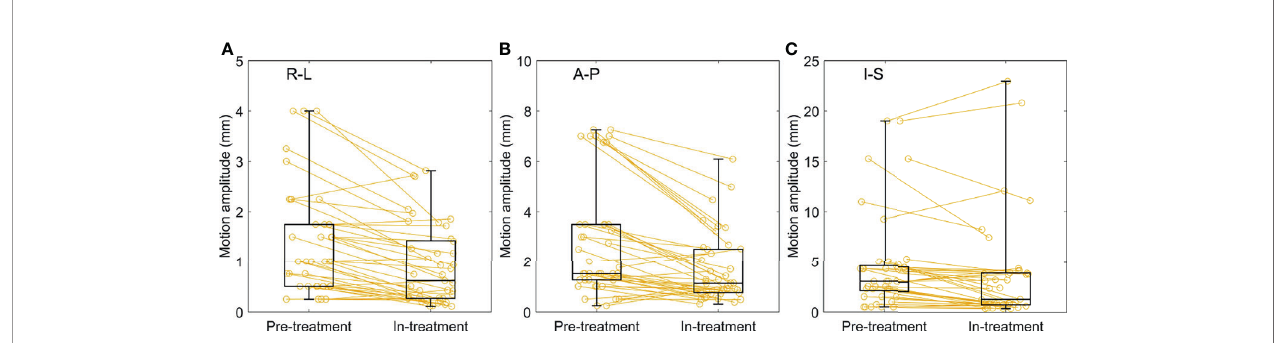
FIGURE 7 | Comparisons of the pretreatment and in-treatment motion amplitudes across 41 treatment fractions of 31 SABR plans in the (A) R-L, (B) A-P, and (C) I-S directions, respectively. The mean values were presented for in-treatment motion amplitudes. SABR, stereotactic ablative radiotherapy; R-L, right-left; A-P, anterior-posterior;